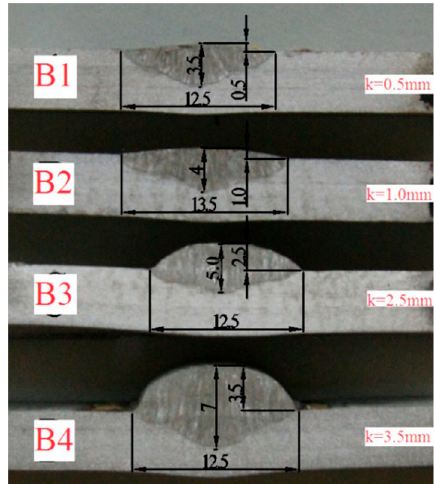
Figure 5. Morphology and size of the molten pool for different repair weld reinforcement heights.